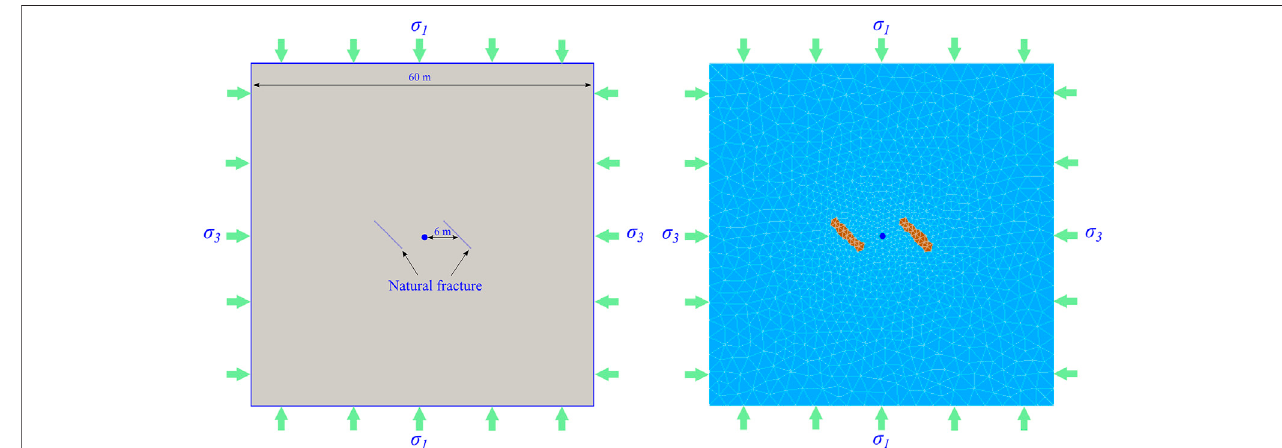
FIGURE 6 | Numerical model for case 2. (A) Geometry model; (B)